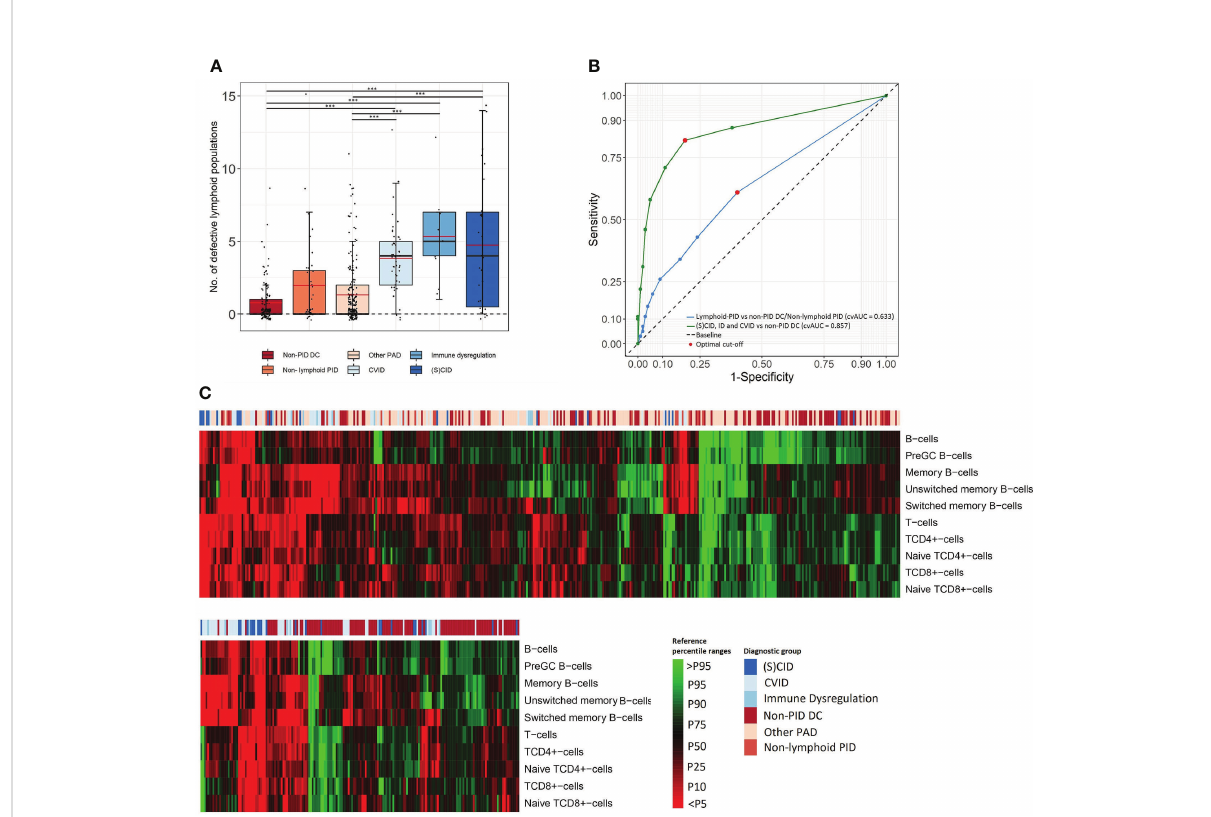
FIGURE 2 Comprehensive characterization of lymphoid defects. (A) Box plots present frequency of total defective lymphoid populations (over the 22 FCM PIDOT variables). The boundaries of the box plots represent the 25th and 75th percentiles. Black and red lines indicate the median and mean, respectively. ***p < 0.001, Mann – Whitney rank-sum test. (B) The receiver operating characteristic (ROC) curve and 10-fold cross-validated Area Under the Curve (cvAUC) to assess performance of PIDOT in relation to the total number of lymphoid defects to distinguish lymphoid-PID against a background of non-PID disease controls and non-lymphoid-PID patients (blue ROC curve) and to distinguish (S)CID, ID, and CVID patients from non-PID disease controls (green ROC curve). The optimal cutoff is presented as red dots. (C) Heatmap on individual patient level of lymphoid populations of the total study population (top) and (S)CID, ID, and CVID patients vs. non-PID DCs (bottom) as obtained by hierarchical clustering. Non-PID DC, non-PID disease controls; PAD, predominant antibody de fi ciency; CID, combined immunode fi ciency; CVID, common variable immunode fi ciency; SCID, severe combined immunode fi ciency; ID: immune